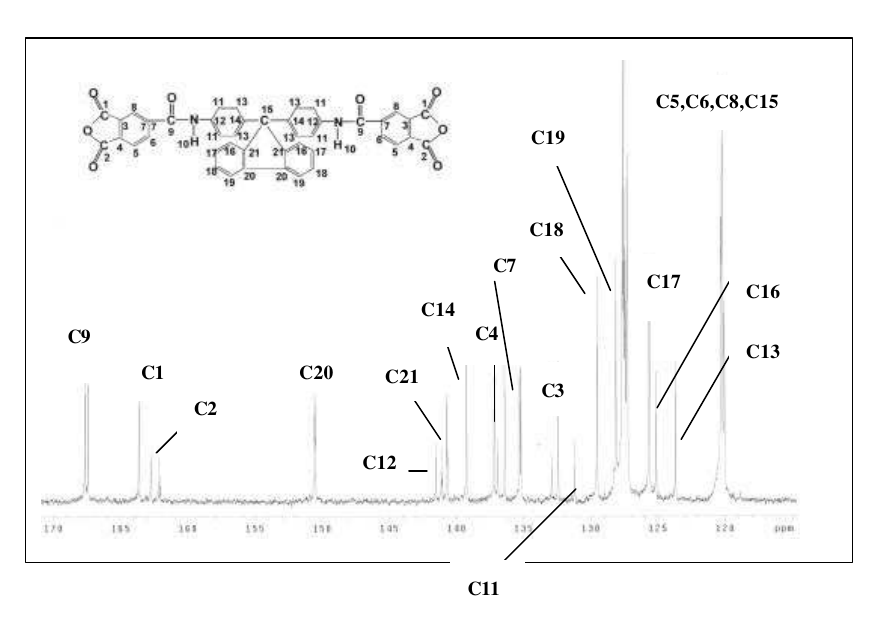
Fig. 1 13 C NMR spectrum of the dianhydride monomer BPFD